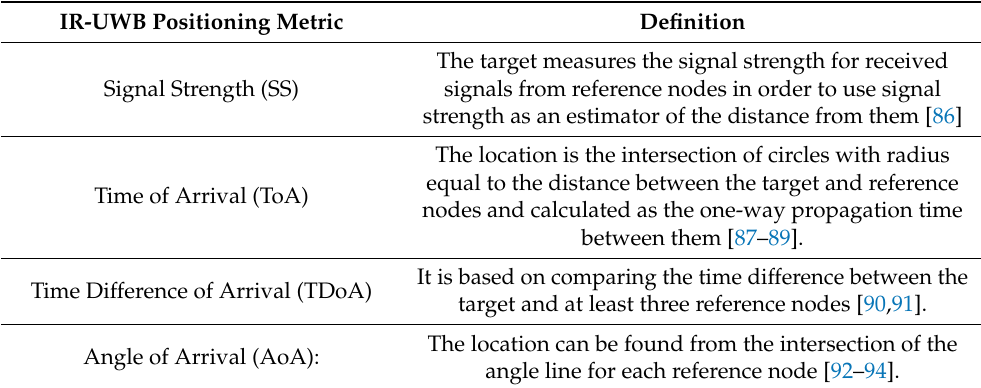
Table 1. IR-UWB positioning system